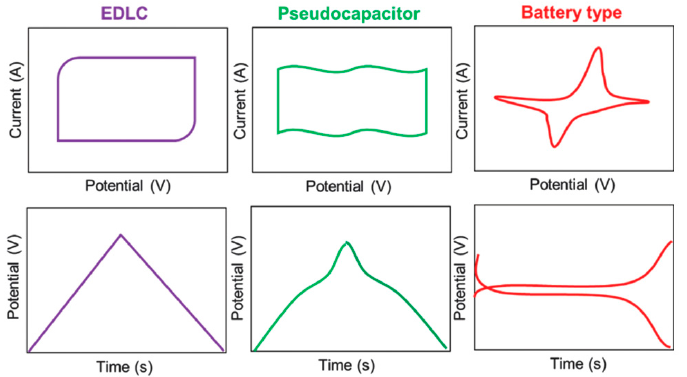
Figure 2. Demonstrative cyclic voltammetry (CV) galvanostatic charge-discharge (GCD) curves of EDLC, pseudocapacitive, and battery-type behaviours. Reprinted with permission from [40]. Copyright 2020, Royal Society of Chemistry.